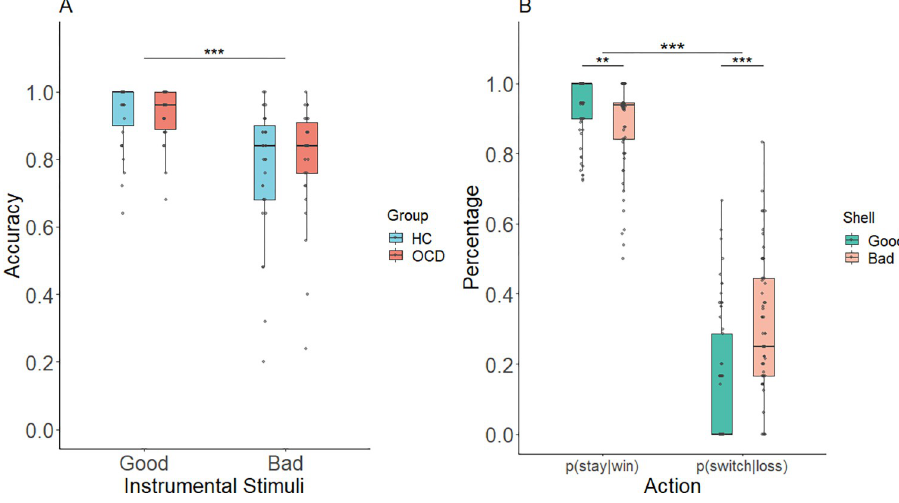
Fig 2. Performance during instrumental training stage. (A) Mean accuracy for good and bad shells (B) The effect of reward and punishment feedback on subsequent behaviors. The graph is collapsed across group as there was no significant group difference. “ � ”: p < 0.05; “ �� ”: p < 0.01; “ ��� ”: p <